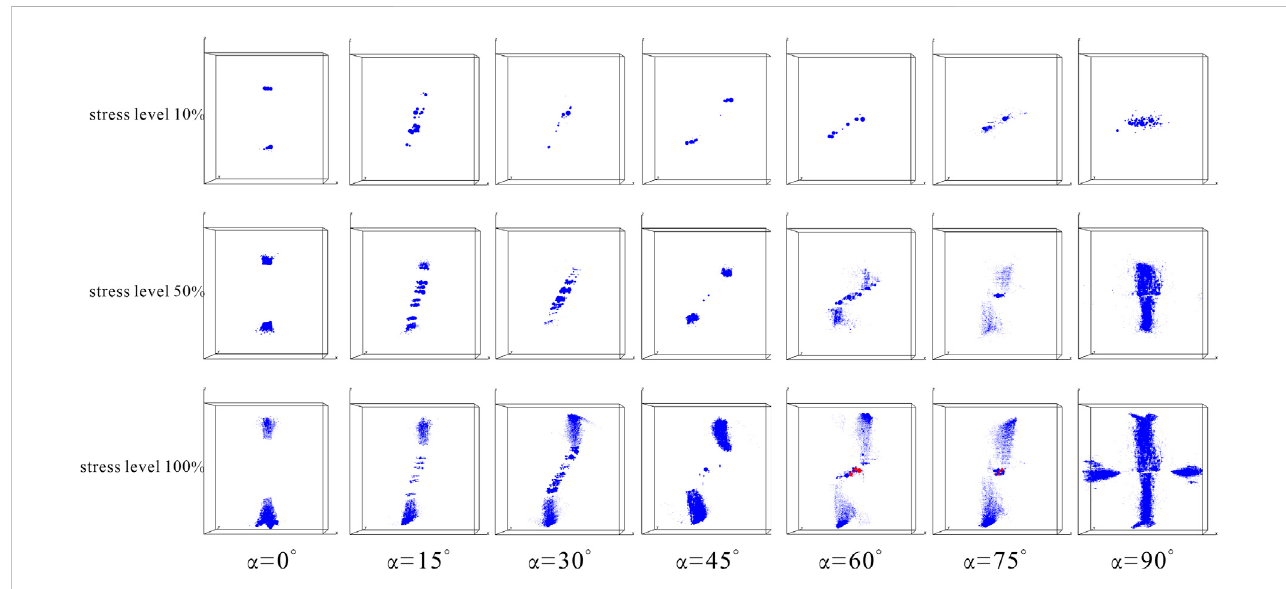
FIGURE 10 Spatial distribution of acoustic emission points at different dip angles and stress